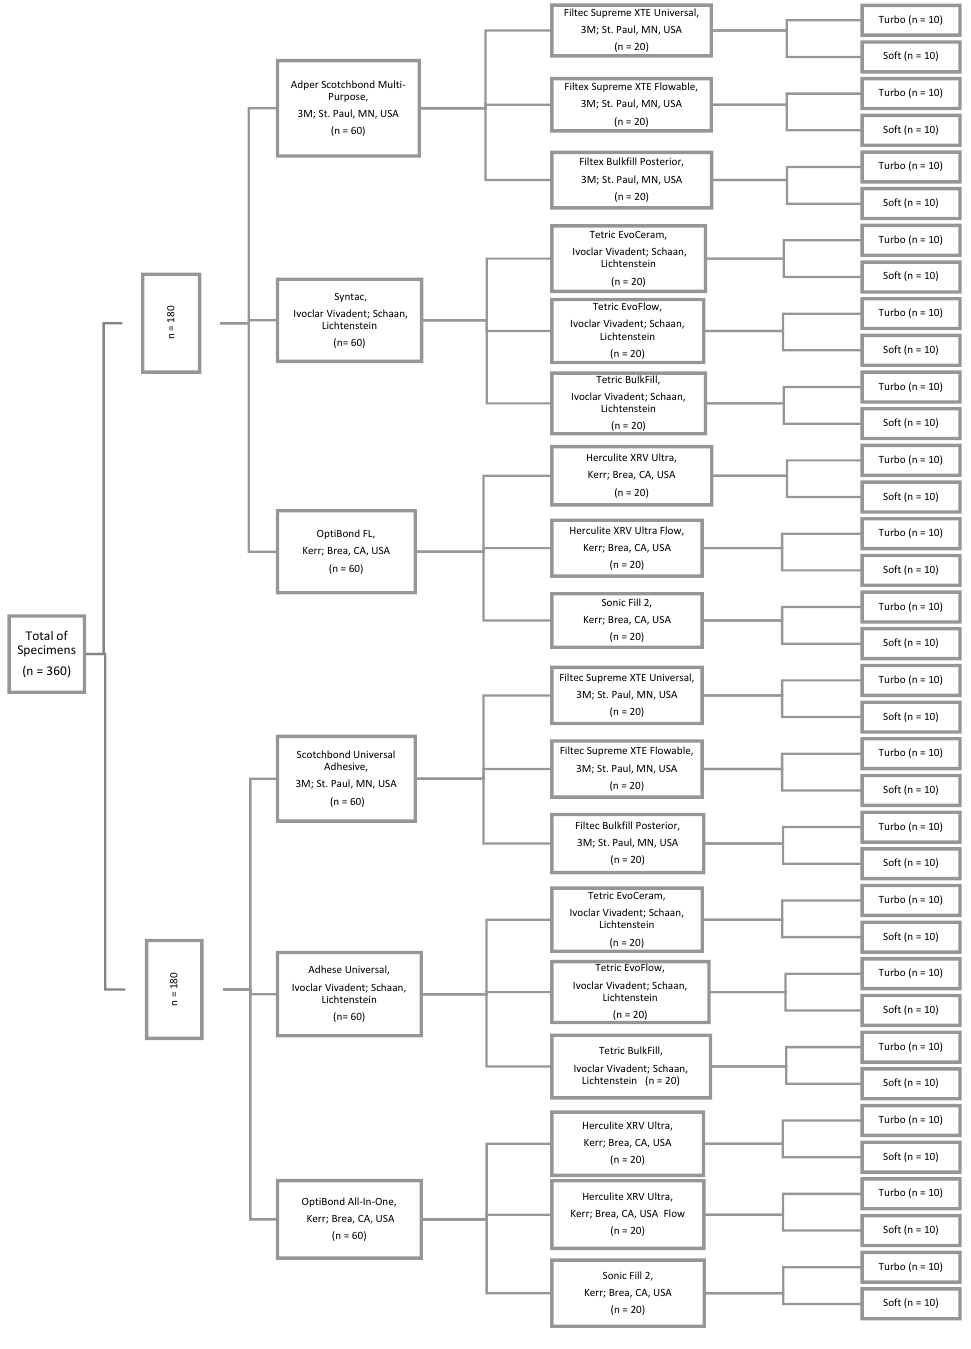
Figure 1. Study design.